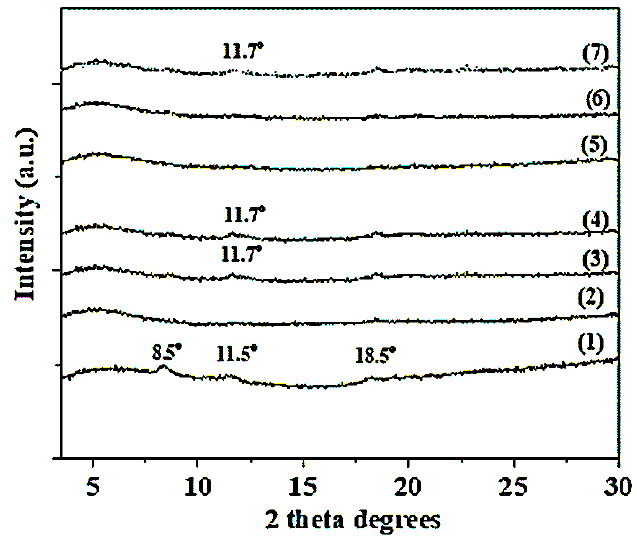
Figure 2. XRD plots of (1) CS/PVOH film, (2) CS/PVOH/5HNT, (3) CS/PVOH/10HNT,